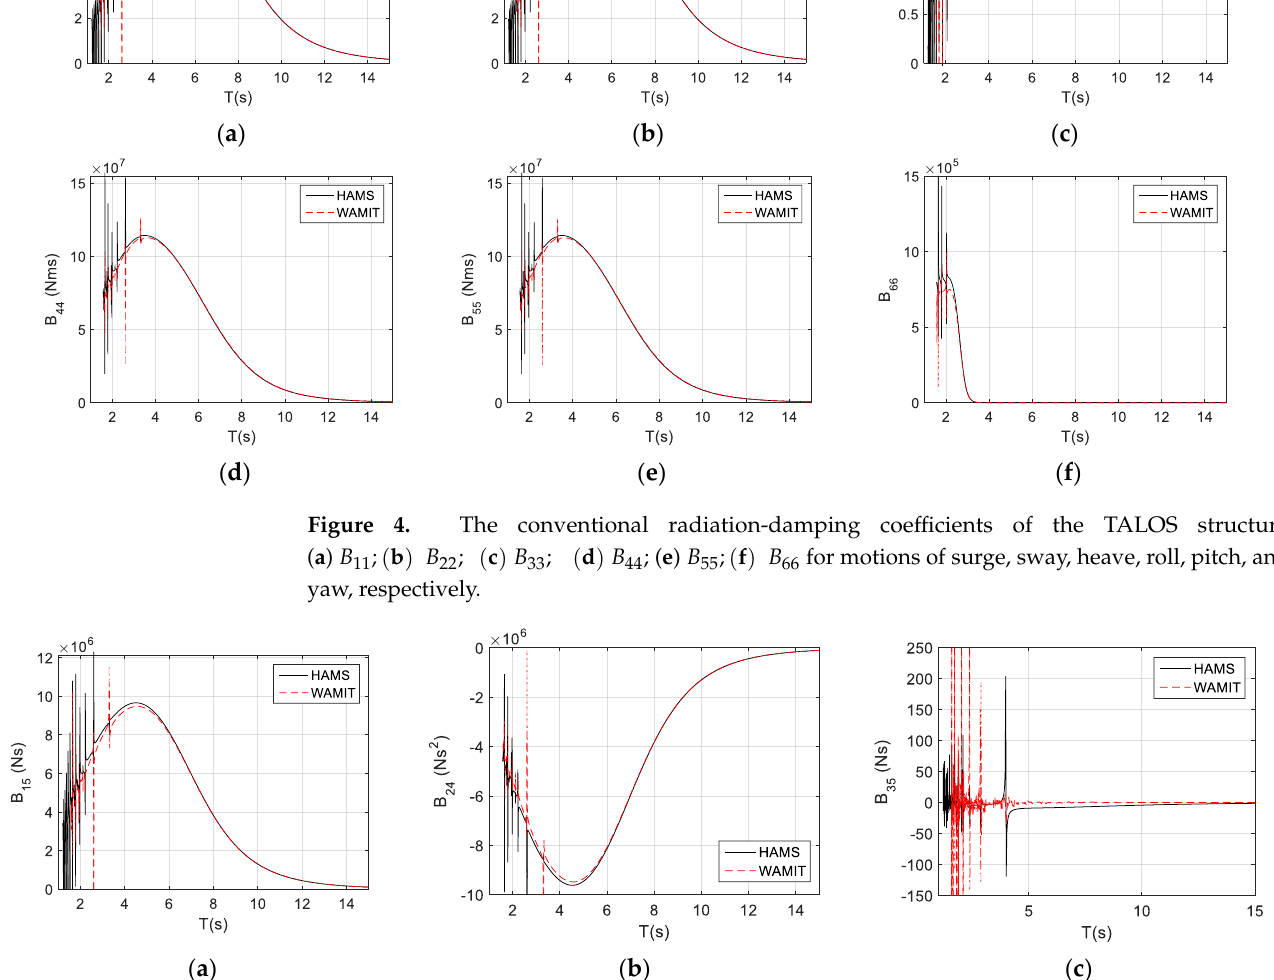
Figure 5. The coupled radiation-damping coefficients for the TALOS structure: ( a ) for surge-pitch coupling ( 𝐵 15 ); ( b ) sway-roll coupling ( 𝐵 24 ); ( c ) heave-pitch coupling ( 𝐵 35 ) .